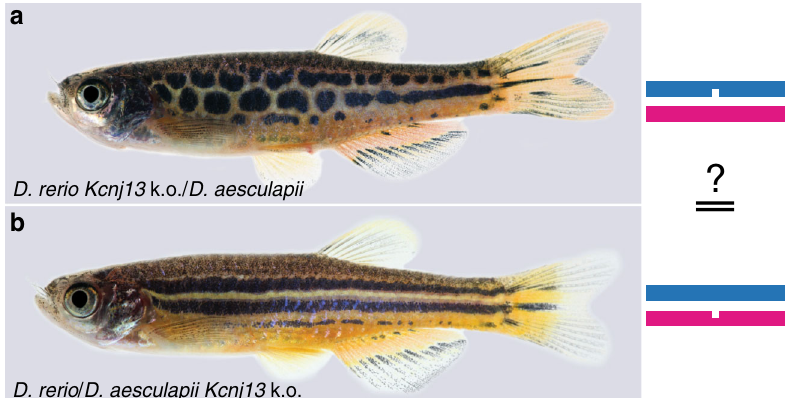
Fig. 5 A reciprocal hemizygosity test to identify Kcnj13 evolution. Two hybrids between D. rerio and D. aesculapii , which are hemizygous for a Kcnj13 loss- of-function mutation. a stripes are interrupted in hybrids carrying the mutant allele from D. rerio ( n > 60, nick in the blue line representing the zebra fi sh genome). b hybrids carrying the mutant allele from D. aesculapii ( n = 6, nick in the magenta line, representing the D. aesculapii genome) are indistinguishable from wild-type hybrids (Fig.